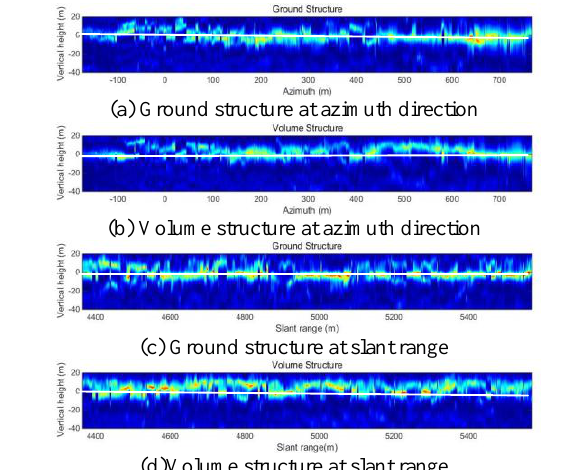
Figure 2. Ground and volume structures at profile positions in figure 1 (a)